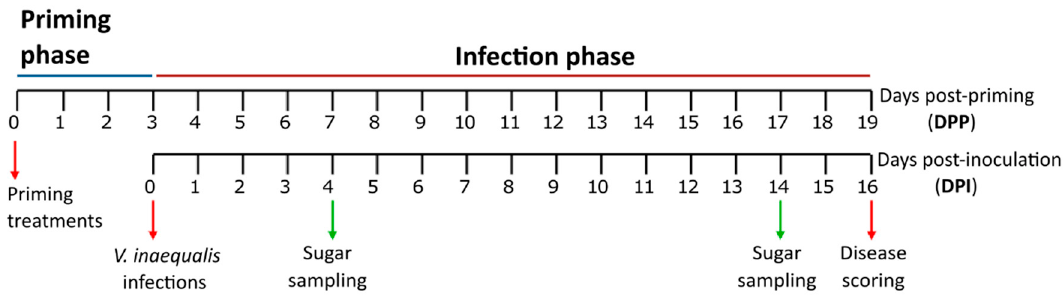
Figure 6. Schematic diagram of the experimental setup used for priming experiments.